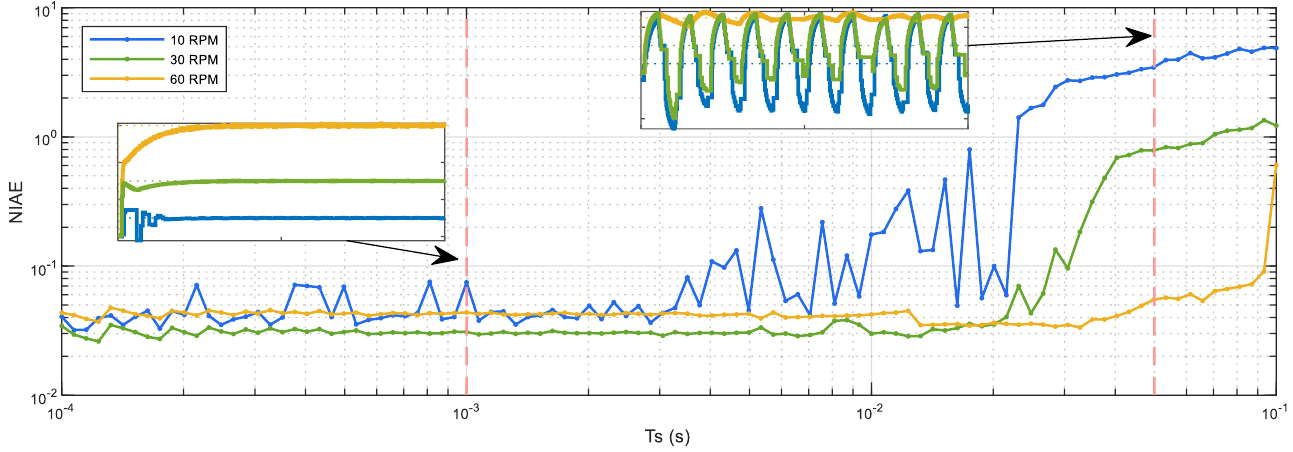
Figure 19. Evaluation of the NIAE values for different sampling periods ( 𝑇 𝑠 ) and different target speeds: 10 (blue line), 30 (green line), and 60 (yellow line) rpm.